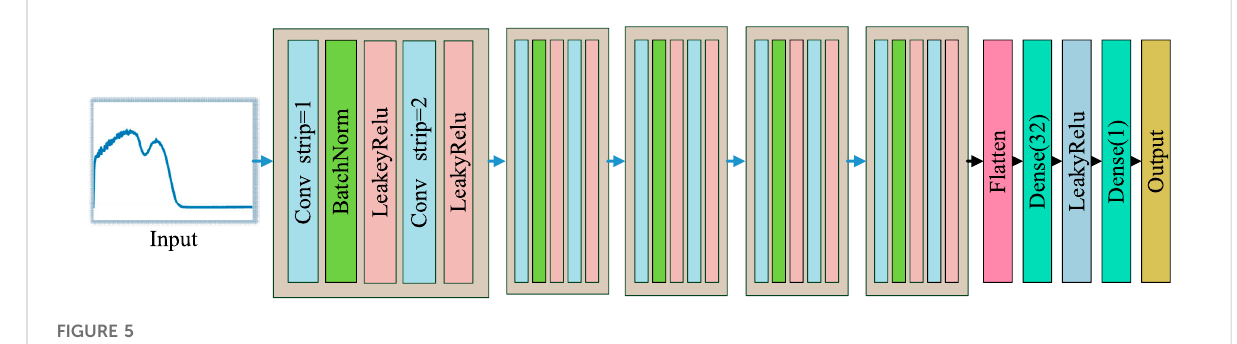
FIGURE 5 CNN model